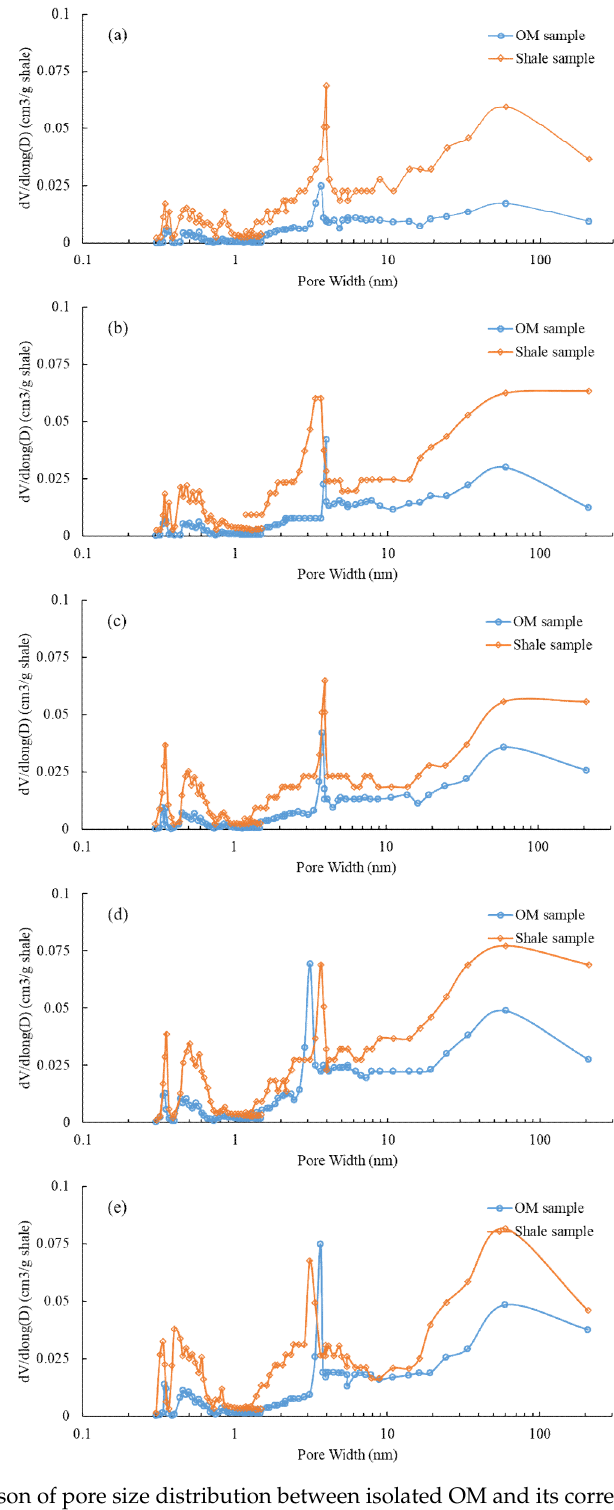
Figure 6. Comparison of pore size distribution between isolated OM and its corresponding bulk shale sample; ( a ) J4-1 sample; ( b ) J4-2 sample; ( c ) J4-3 sample; ( d ) J4-4 sample; ( e ) J4-5 sample.